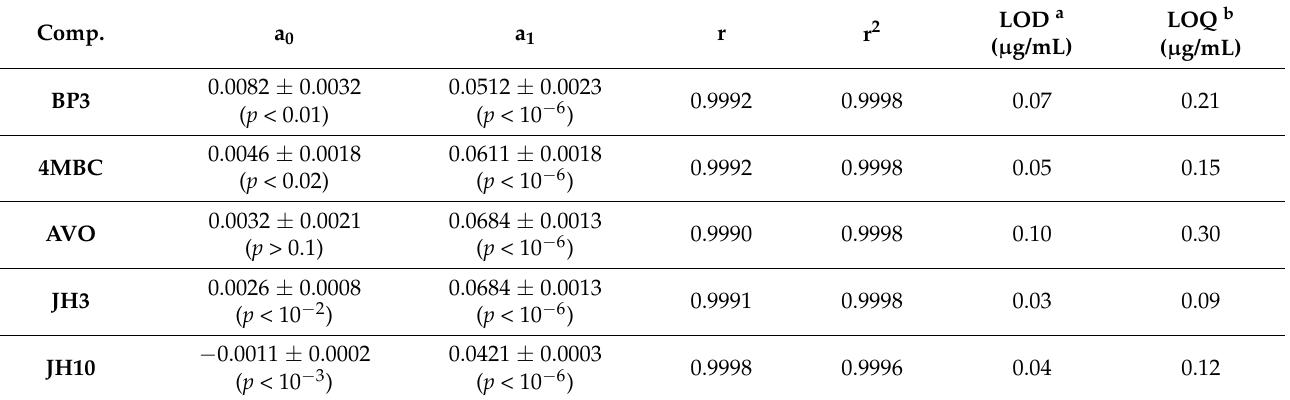
Table 2. Regression analysis results—part 1.